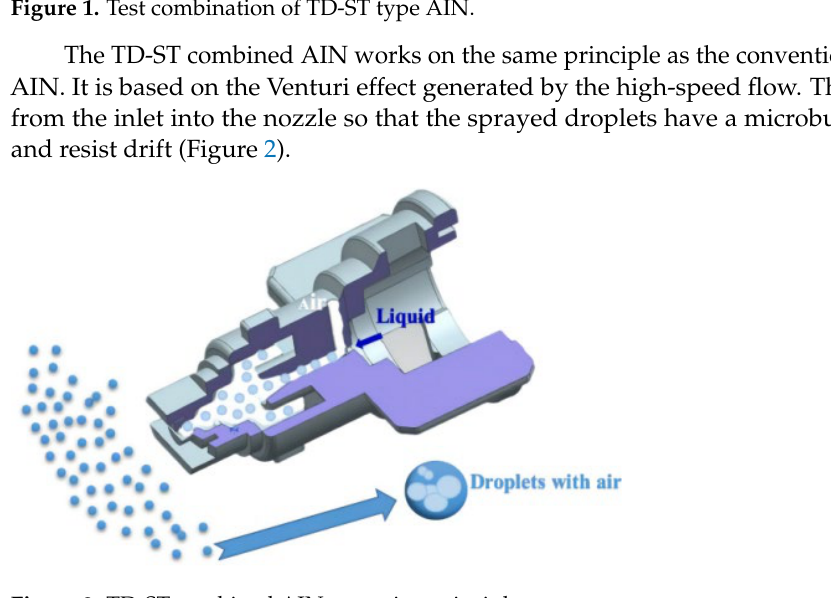
Figure 2. TD-ST combined AIN operating principle.